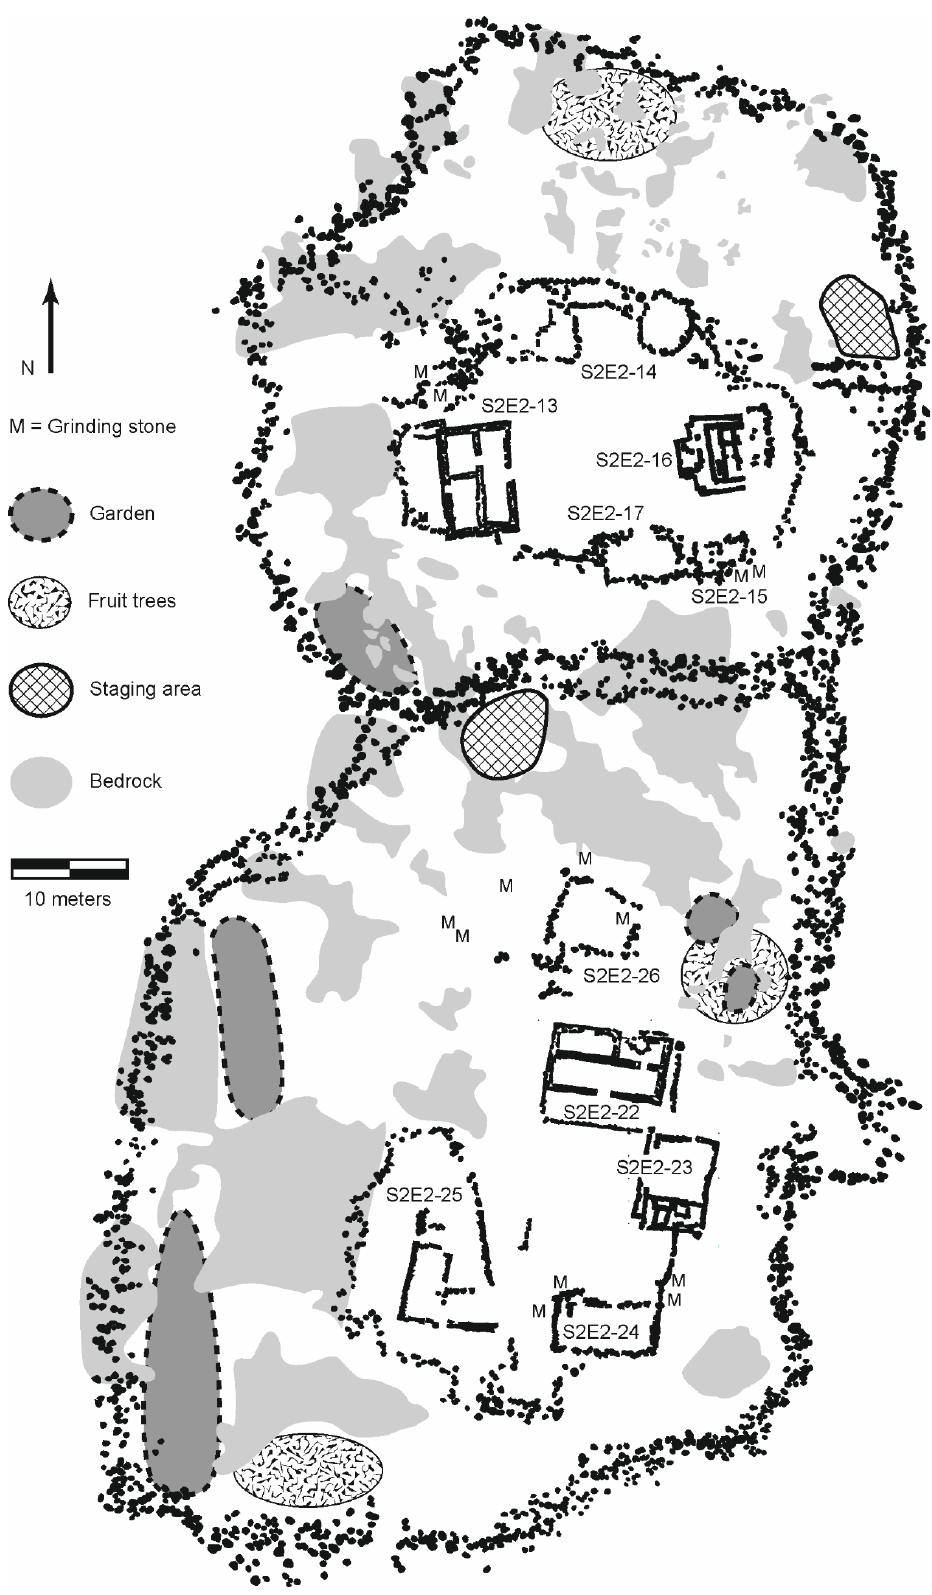
Figure 1. A section of Chunchucmil (Mexico) demonstrating the spatial arrangement of architecture and garden areas and the frequency and complexity of edges to areas without soil (i.e., bedrock) (source: [35], reprinted with permission from Scott